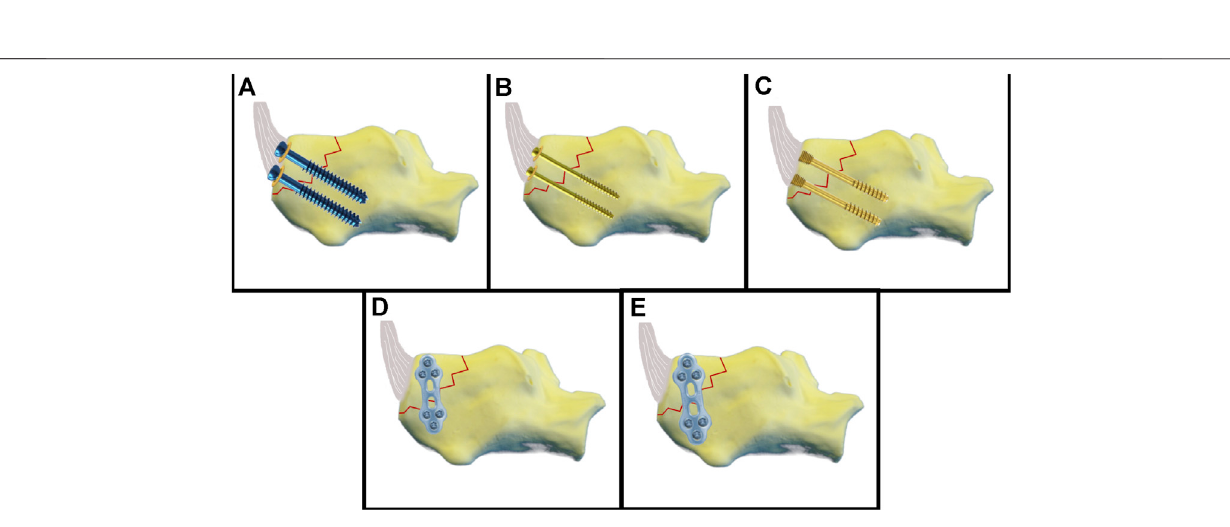
Frontiers in Bioengineering and Biotechnology |